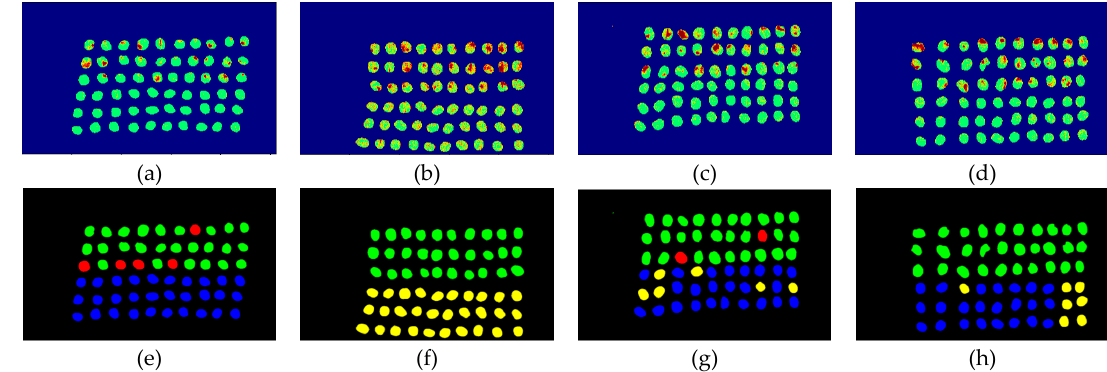
Figure 42. Results of green coffee bean CEM-SVM+SB_CTBS 20 bands. (a-d) SVM classification results, (e-h) final visual images.